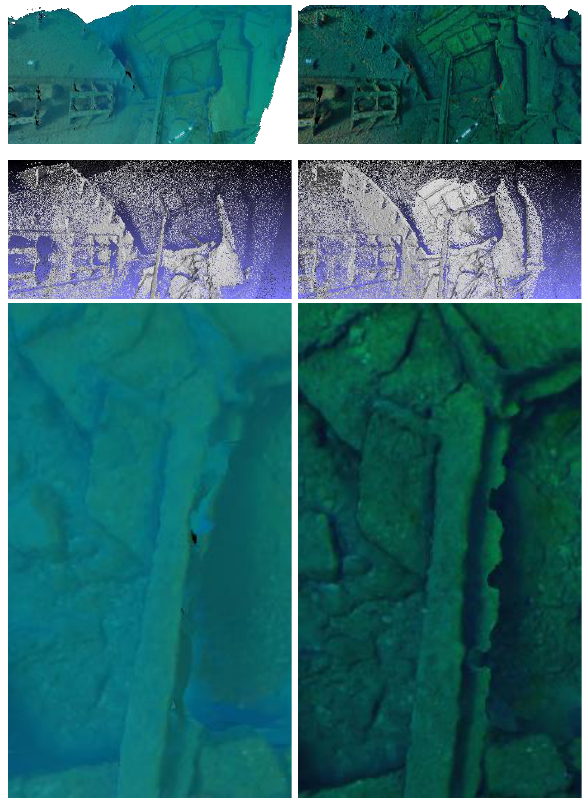
Figure 7. Mesh simplification. Left : original mesh; right : simpli- fied